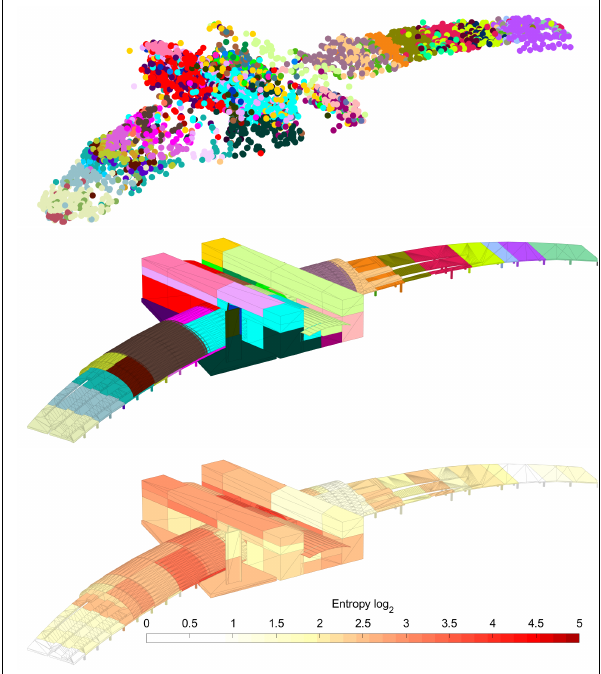
Figure 11. Top: PS-point on Berlin Central Station . Each extracted cluster in a different color. Middle: Mesh colored with the assigned PS-cluster. Bottom: Entropy for each mesh segment. A lower entropy indicates a good match between the cluster and the